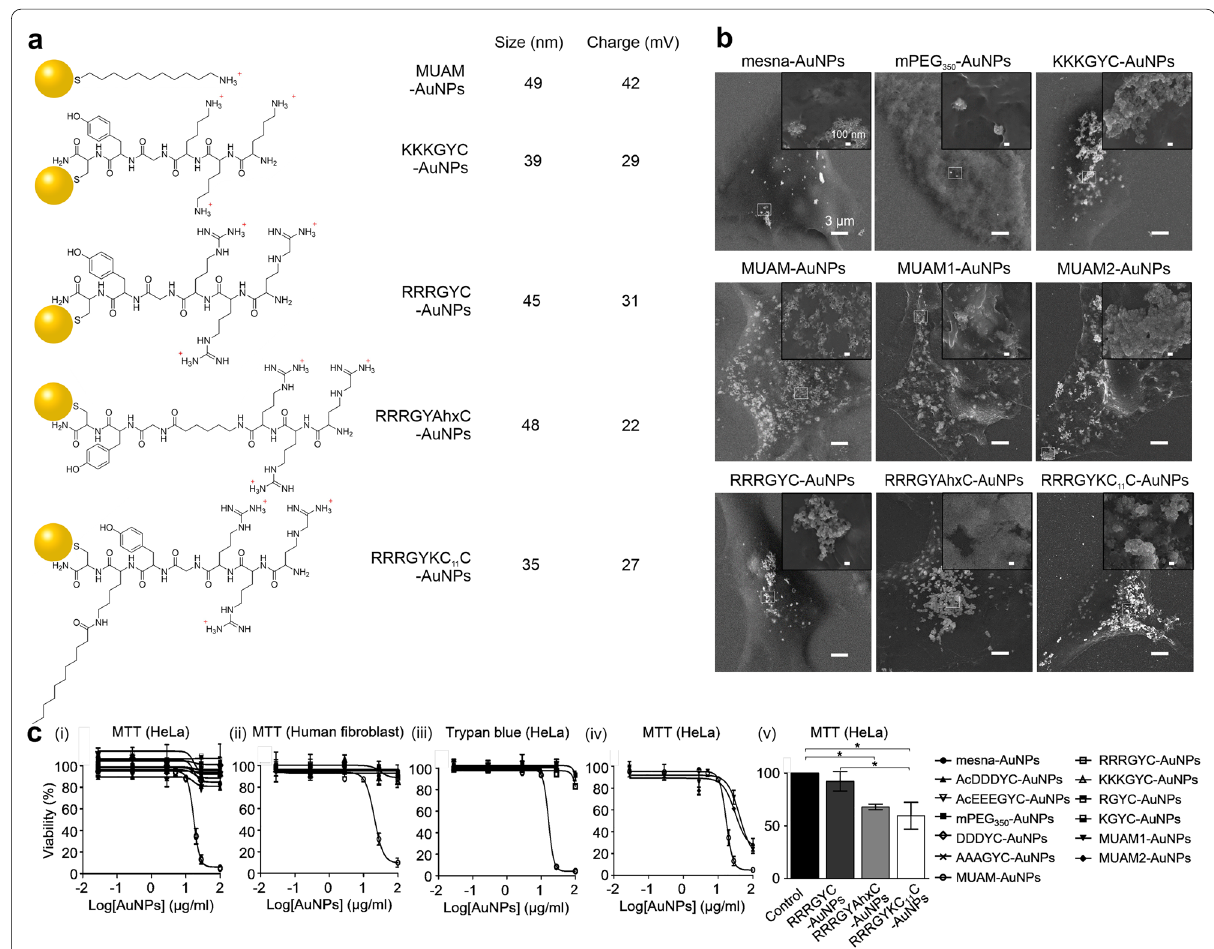
Fig. 3 AuNPs modified with various cationic ligands and their biological effect. a Chemical structure and characterization of five different cationic AuNPs. b FE-SEM imaging of modified AuNP-treated HeLa cells. c Effect of modified gold nanoparticles (AuNPs) on cell viability (both MTT and Trypan blue